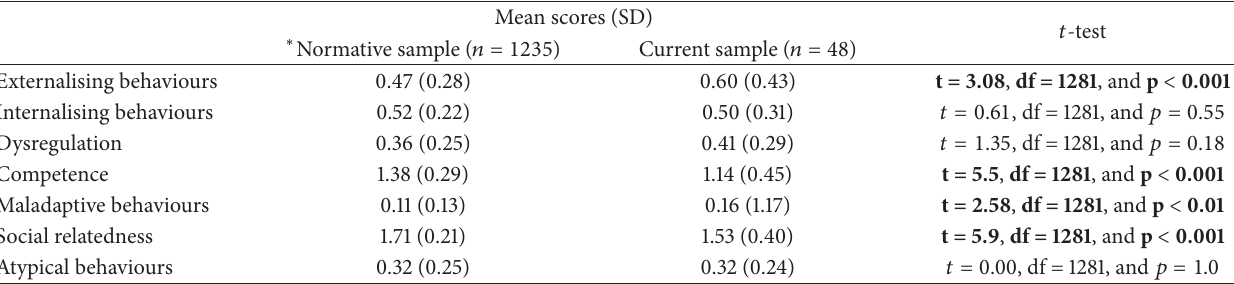
Table 3: Comparisons of our sample with a normative sample on the ITSEA.